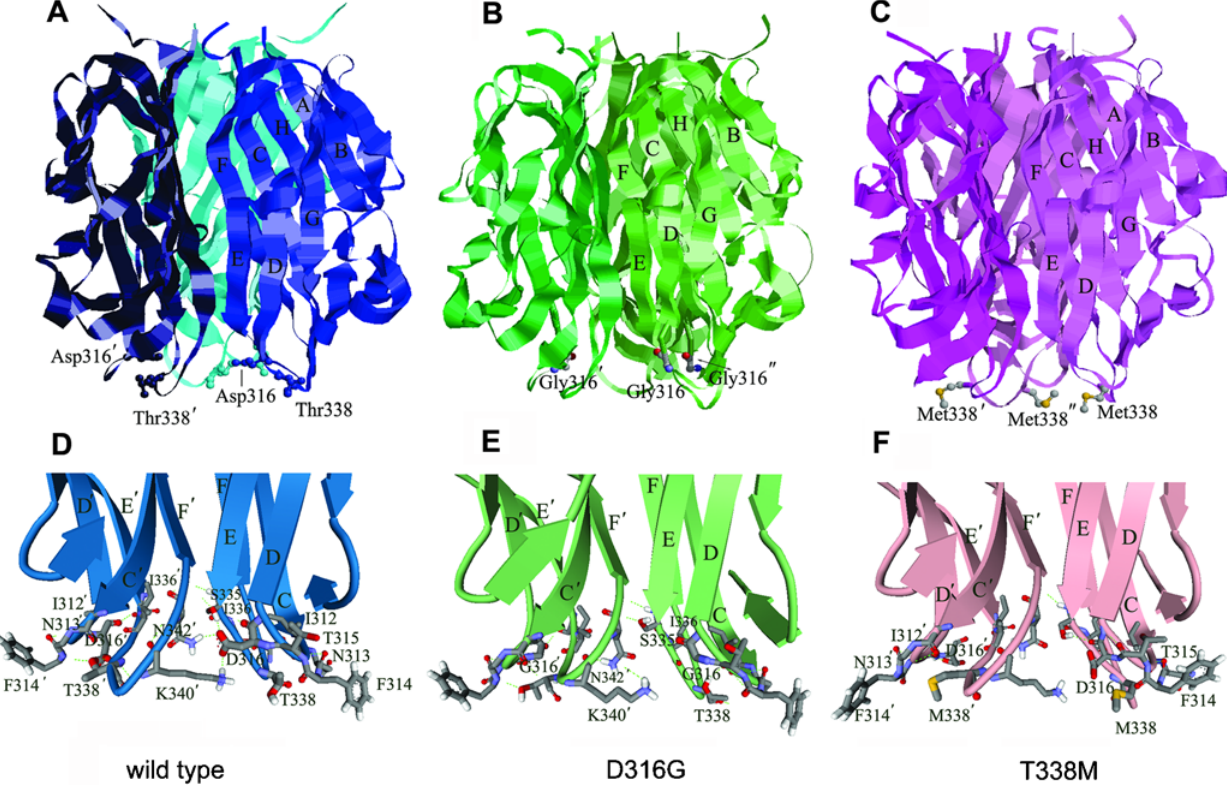
Figure 6. Structures of wild type, D316G and T338M EDA. (A)–(C). Locations of p.D316G or p.T338M mutation sites in the quaternary structure of the EDA homotrimers. The EDA trimers are shown as ribbon rendering with mutation residues rendered in stick and ball, beta strands and the mutated amino acids are labeled. (D)–(F). Close up views of the mutation sites of D316G, T338M and wild type EDA proteins. The amino acid backbones are represented by ribbons with arrows. Side chains have been omitted from most residues for clarity. Hydrogen bonds are indicated by dashed green lines.